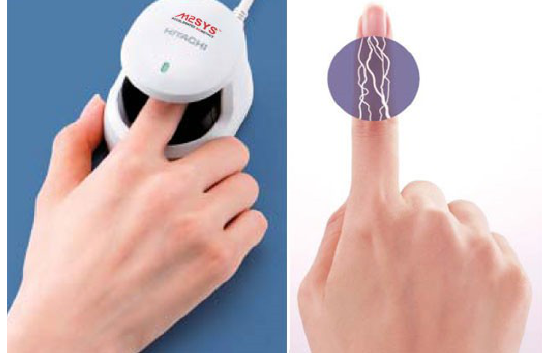
Figure 4. A finger vein scanner [28].